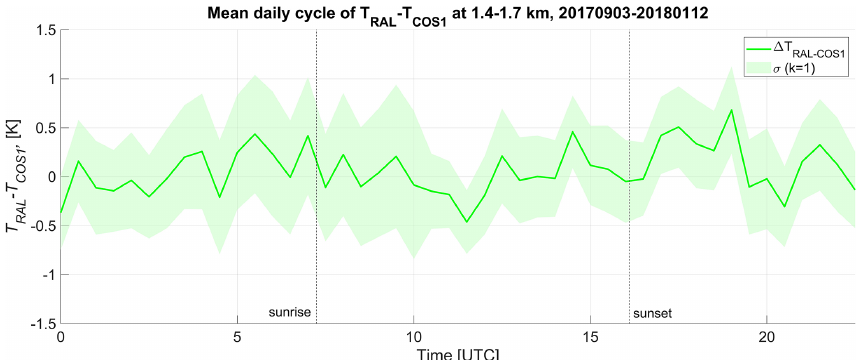
Figure 12. Differences between RALMO and COSMO temperature at 1400–1700ma.s.l. during September 2017–January 2018. The green shading accounts for the k = 1 standard deviation of the differences. The dashed vertical lines show the sunrise and sunset time on 12 January 2018; the mean daily cycle shows that no artefacts are introduced by the application of f ((cid:56)) during